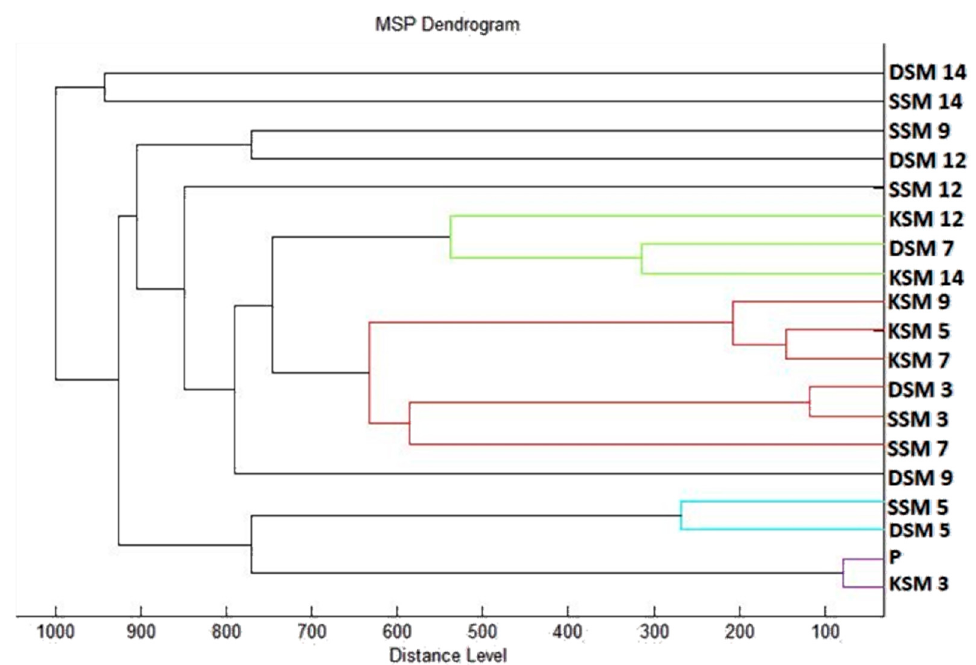
Figure 2. Dendrogram of S. maltophilia generated using MSPs of the planktonic cells and the control. SM, S. maltophilia; K, control; S, glass; D, wood; and P, planktonic cells.